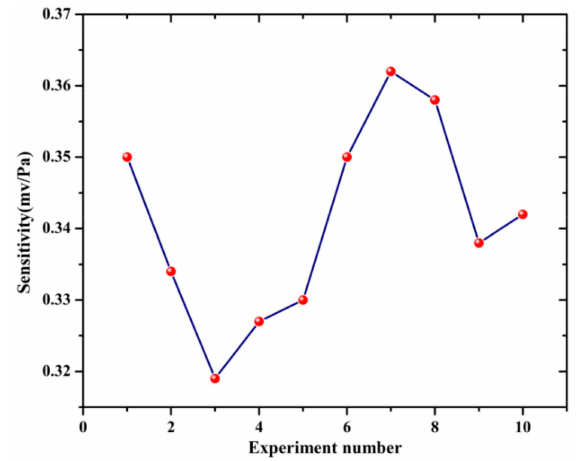
Figure 16. The sensitivity of optical fiber PD sensing